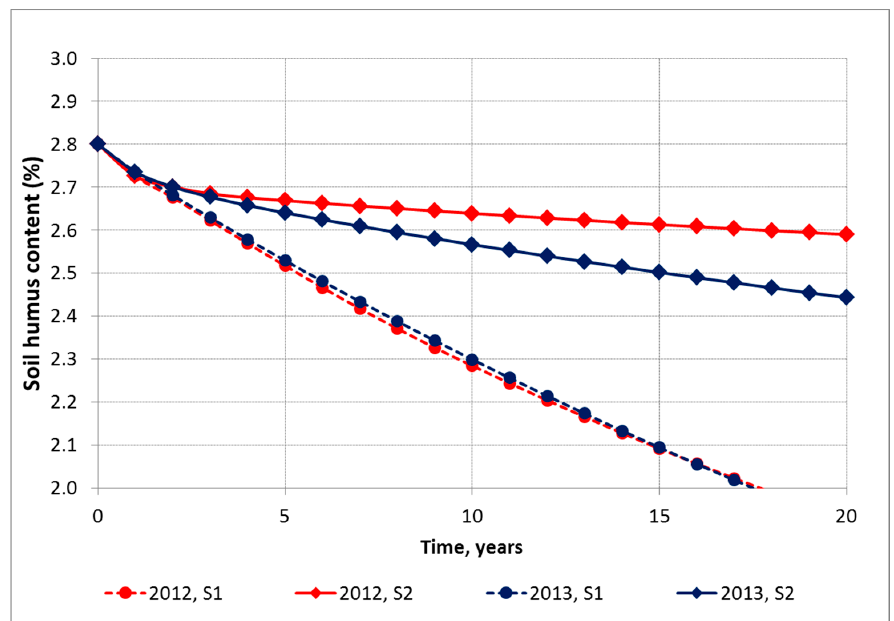
Figure 4. Long-term dynamics of soil humus content under different land use strategies for two benchmark weather realizations. Plant—spring wheat. Weather datasets—2012, 2013 vegetation periods in Men’kovo Experimental Station (Leningrad Region, Russia). S1—traditional technology—all above-ground biomass removed from the field, S2—“green manure” technology —all above-ground biomass remained on the field.